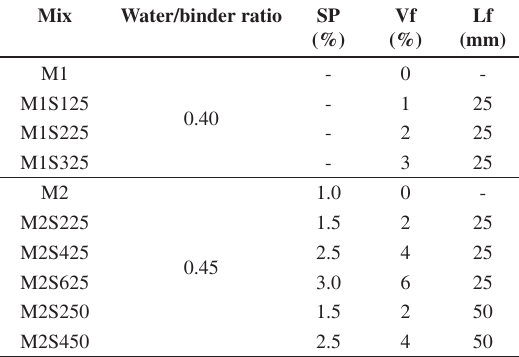
Table 2. Composition of the composites produced in the study. Mix Water/binder